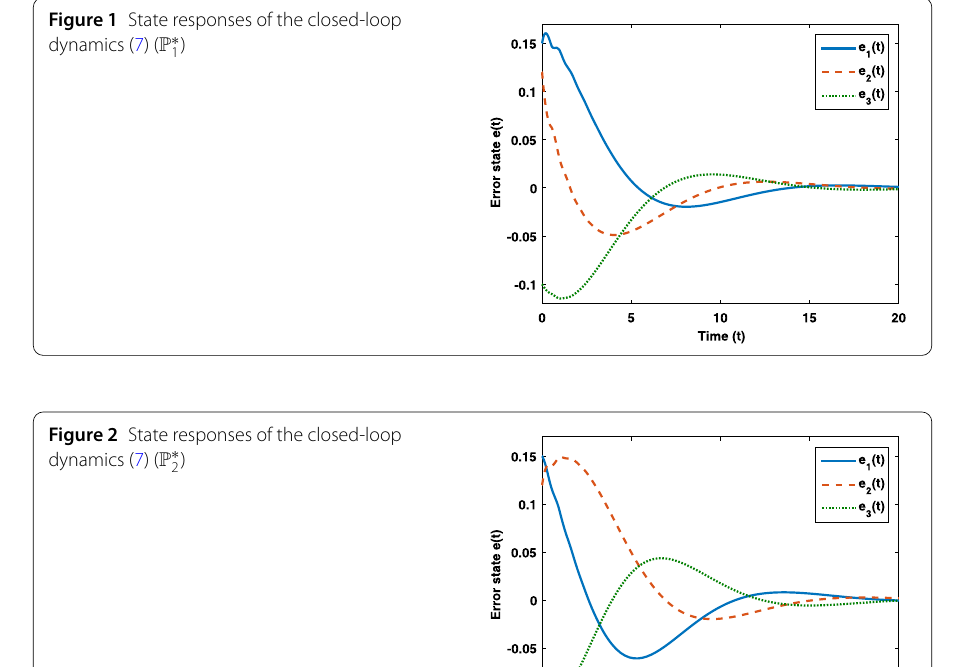
Figure 1 State responses of the closed-loop dynamics (7) ( P ∗ 1 )